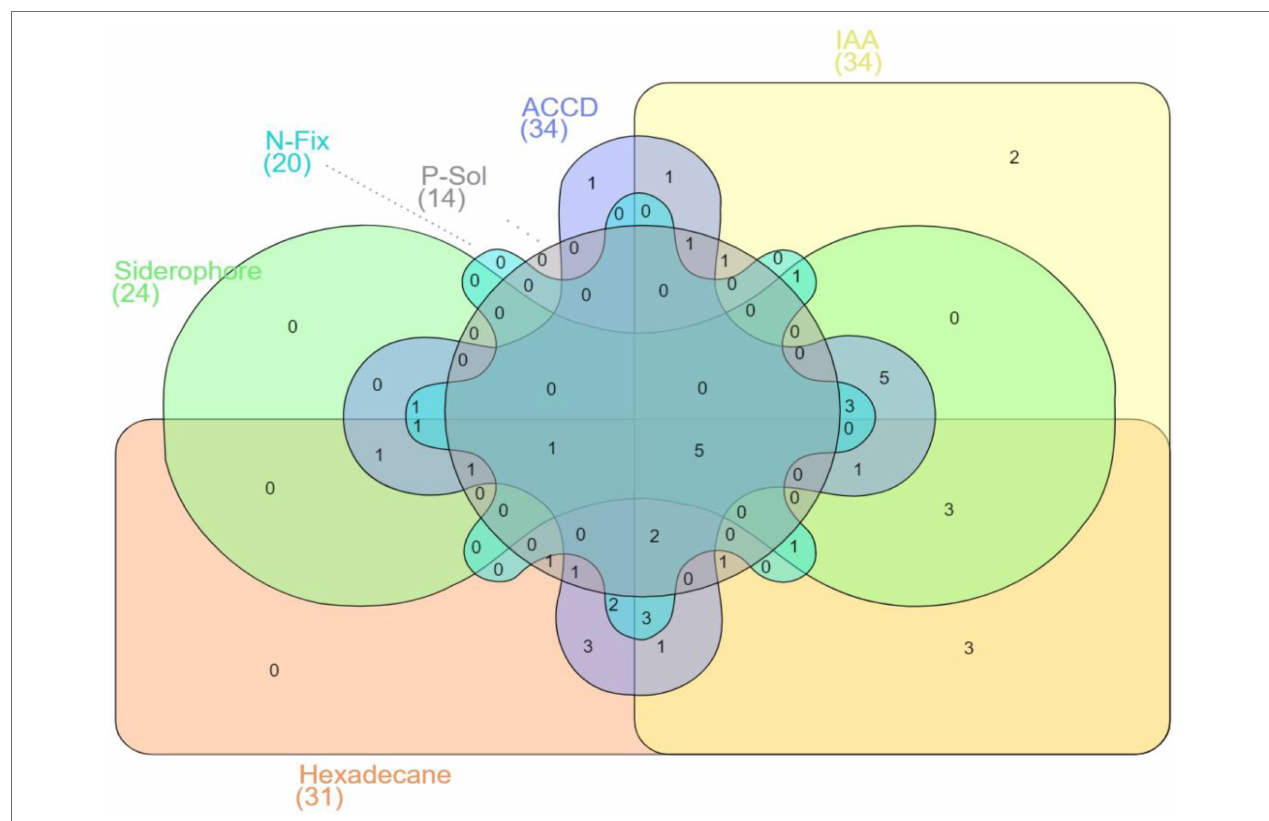
FIGURE 2 | Venn diagram representation of 50 rhizobacterial strains, showing positive results for hexadecane degradation potential and different plant growth- promoting (PGP) traits (with five strains showing positive results for all the traits under